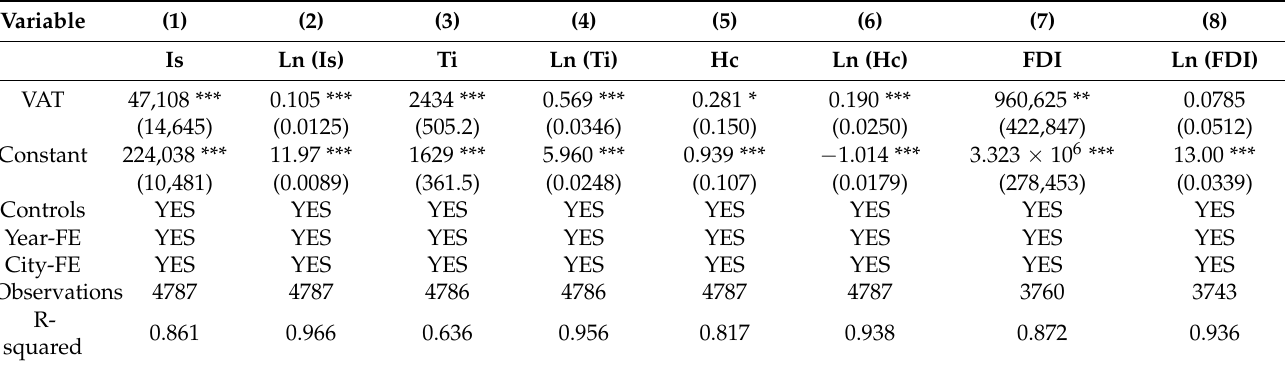
Table 6. Analysis of potential impact